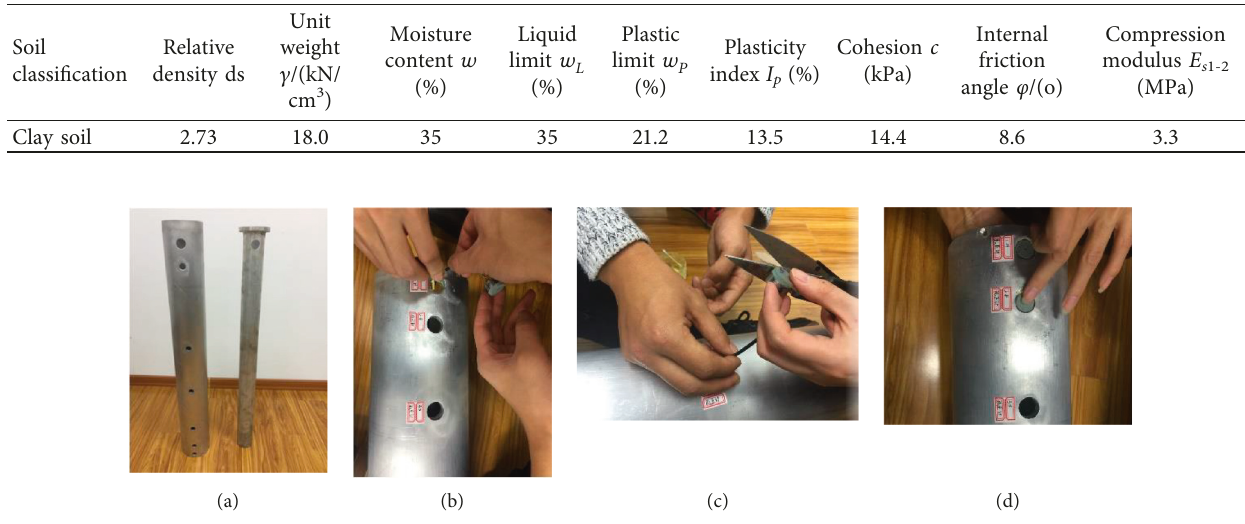
Figure 2: Images showing the sensor installation process (unit: mm): (a) opening, (b) applying glue, (c) protection, and (d)